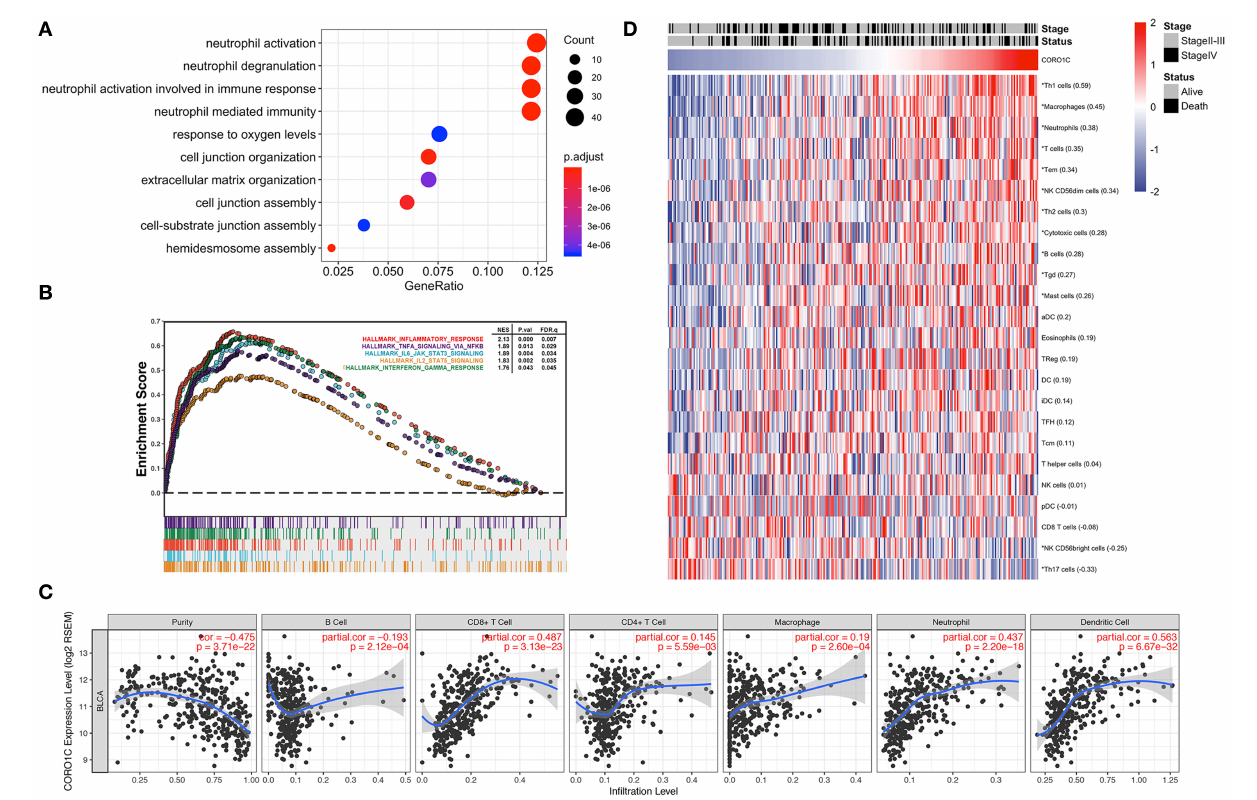
FIGURE 7 | Evaluation of CORO1C expression and tumor immune infiltration based on TCGA-BLCA data. (A) Biological process of gene ontology enrichment for WGCNA purple module. (B) Integrated plot presented some top GSEA enriched immune-related pathway associated with CORO1C expression. (C) Evaluation of CORO1C expression level and immune infiltration level in BC via TIMER tool. (D) Relationship between CORO1C and 23 types of immune cells via ssGSEA analysis. The Pearson correlative coefficients were marked following the name of each immune components (“*” represented statistical significance p <